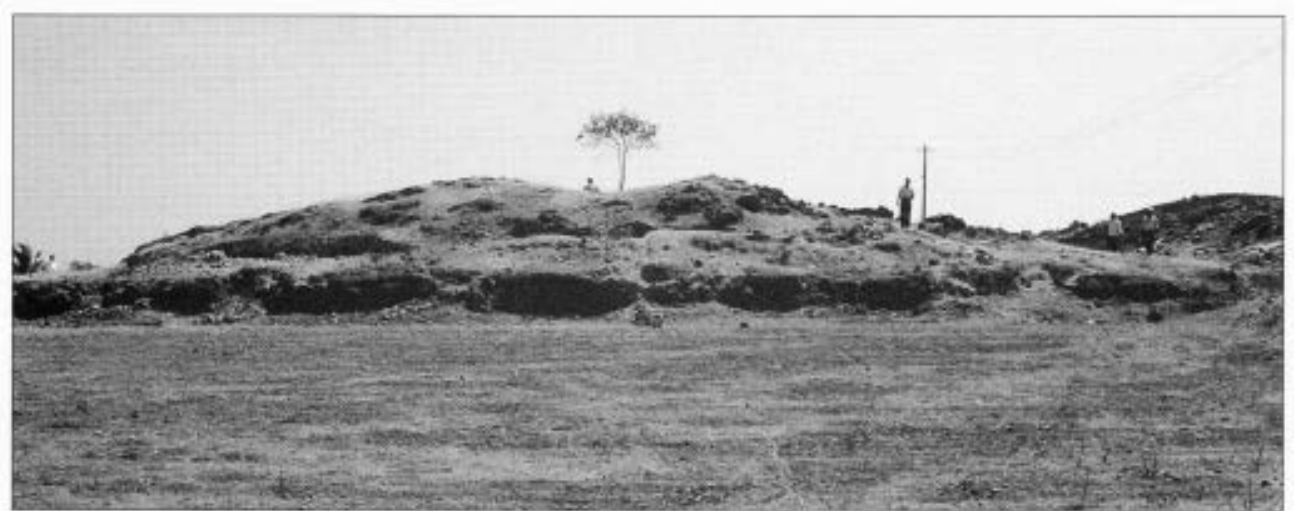
Figure 1 Ashmound at Kupgal near Sanganakallu village, Karnataka State. The mound is approximately 50 m long and 5.5m